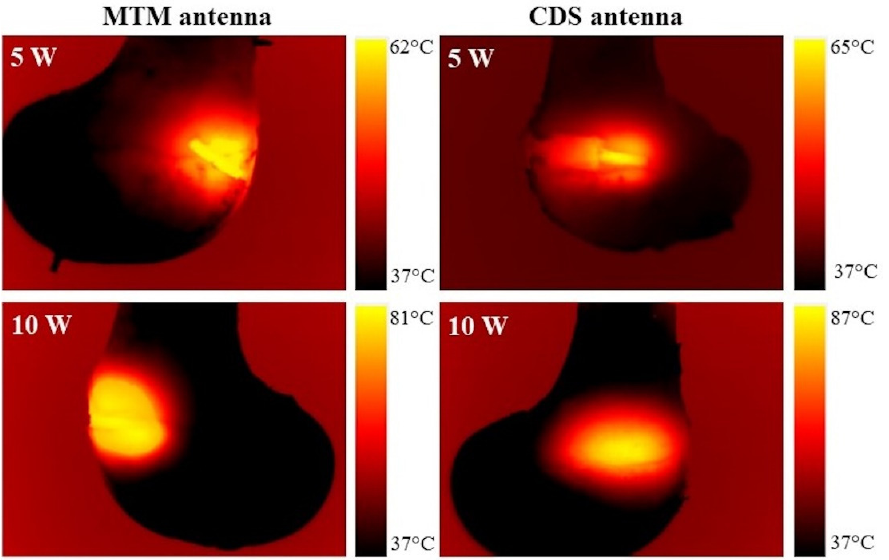
Figure 8. Thermal distribution generated by an MTM and CDS antenna in porcine ex vivo tissue.